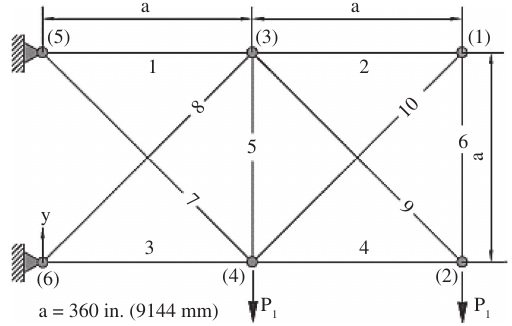
Figure 6: A Planar 10-Bar Truss Structure